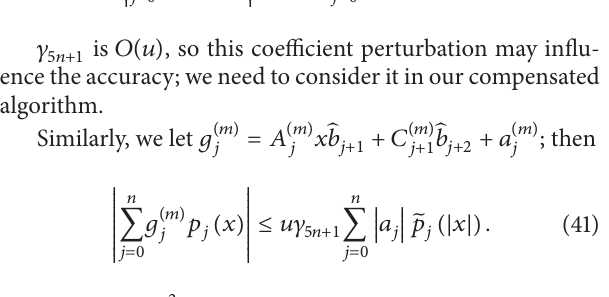
Algorithm 9: Addition of a double-double number and a double number.